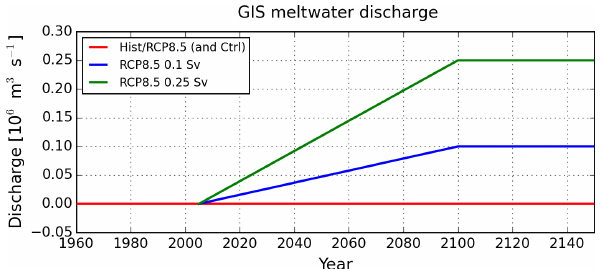
Figure 1. Prescribed idealized meltwater discharge from the Green- land ice sheet to the North Atlantic. The distribution along the coast of Greenland follows the climatologies by Bamber et al. (2012) and Martin et al.